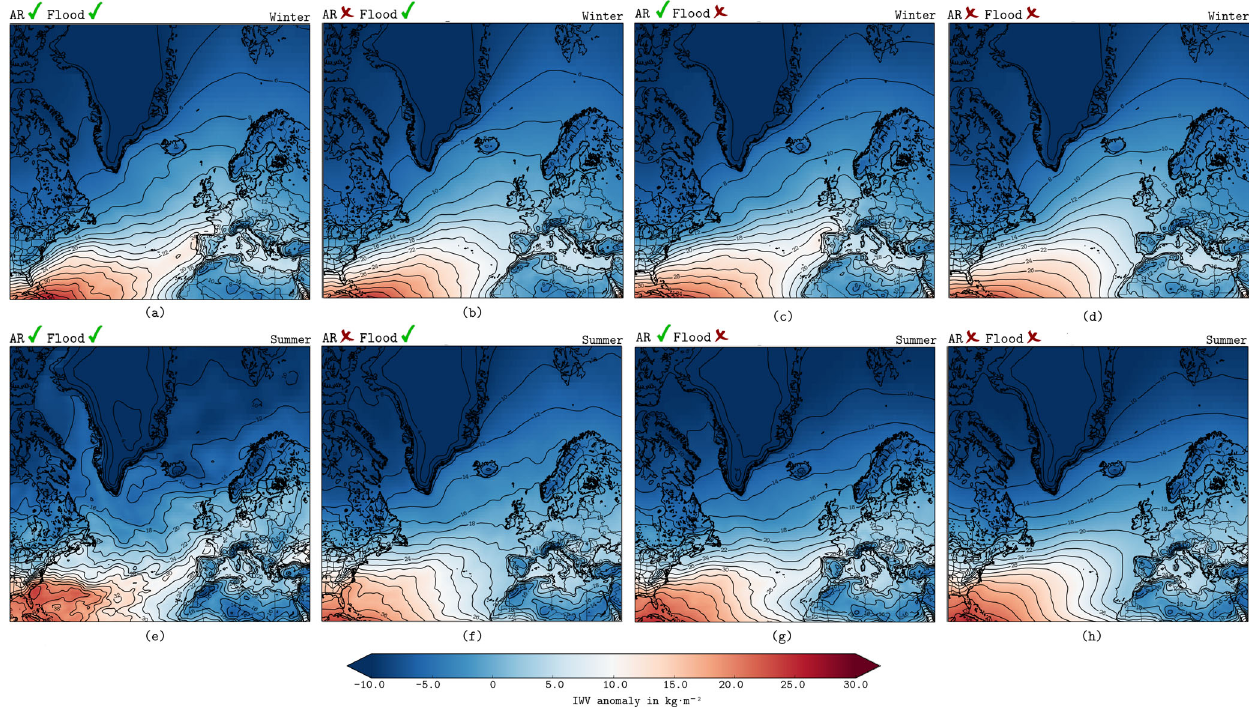
Figure A2. Same as Figs. 6 and 7 but with IWV